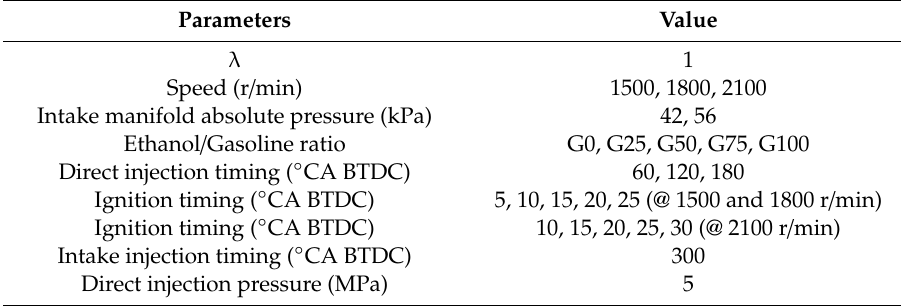
Table 5. Experimental conditions.